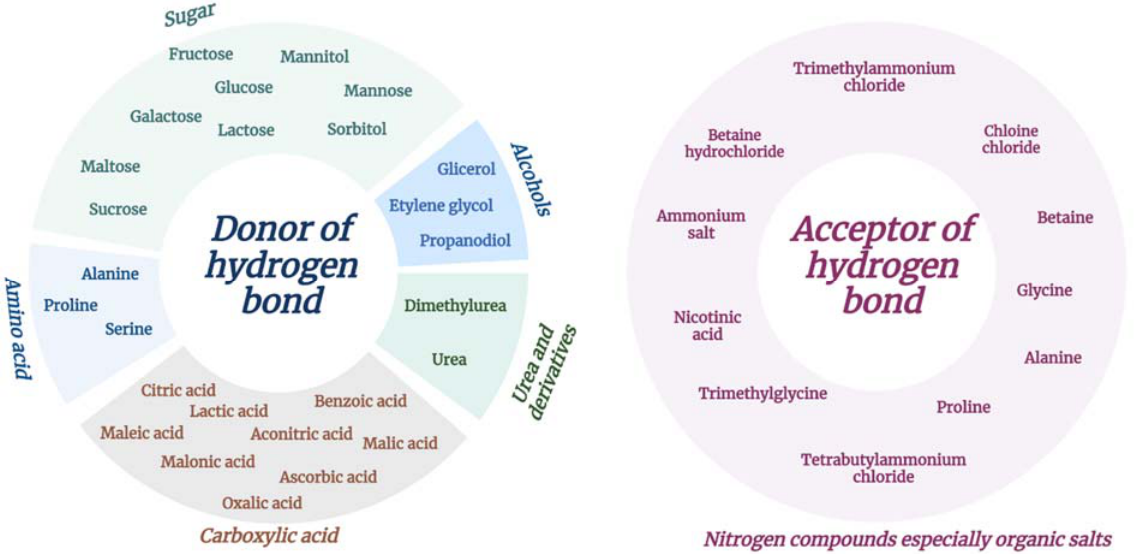
Figure 3. Components of natural deep eutectic solvents divided into hydrogen bond acceptors and hydrogen bond donors) (created with BioRender.com).